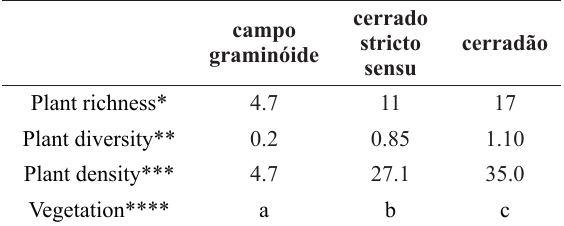
Vegetation indexes of the evaluated sites (Oliveira et al.